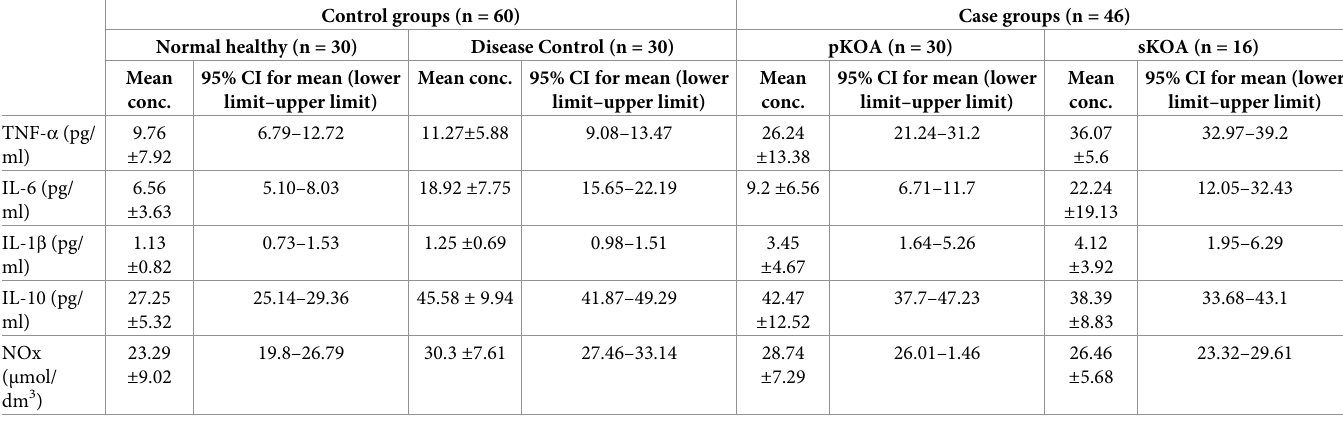
Table 2. Mean serum levels of the analytes assayed in case and control